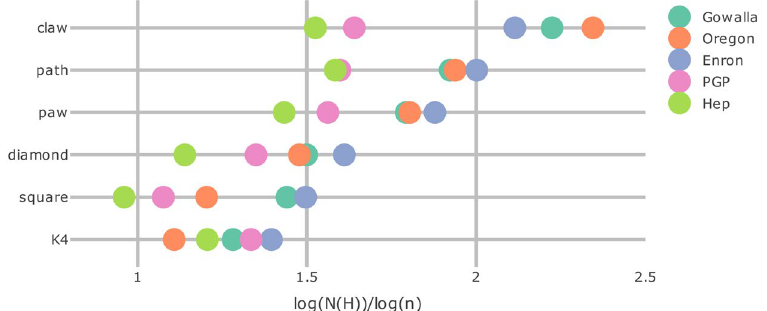
Figure 5. Number of graphlets on four vertices in five data sets on logarithmic scale: N H log( ( )) / n log( ) . The ordering of the six different graphlets is from the most occurring in the hidden-variable model to the least. The values of the graphlet counts are presented in Supplementary Table 1.